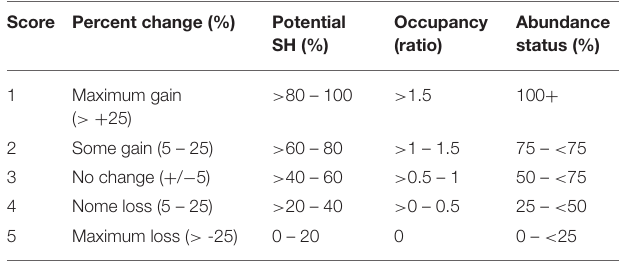
TABLE 1 | Definitions of the bins used to factor indicators into scores that range from 1 to 5 (SH, suitable habitat).